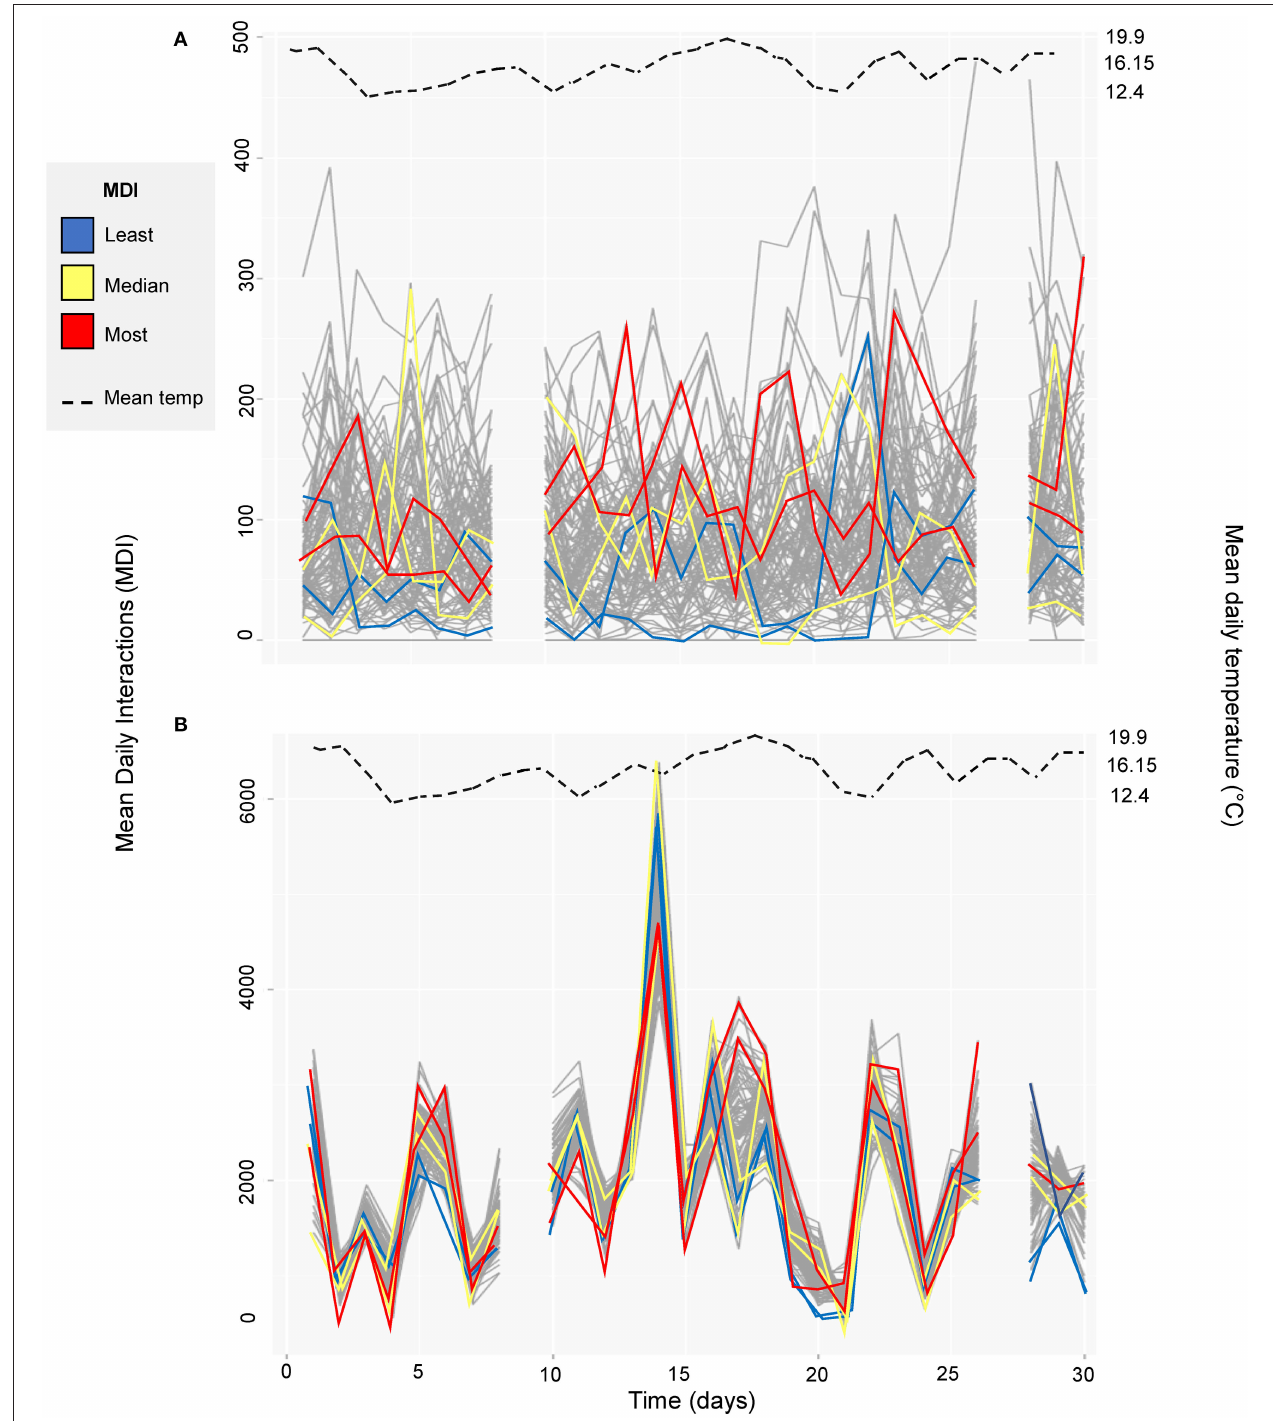
FIGURE 4 | Mean daily interactions across time (01/10/2014 to 31/10/2014 with days excluded from the study omitted) in (A) feeding zone, and (B) non-feeding zone. An illustrative subset of individuals are highlighted: two individuals with the least mean daily interactions (blue, cow ID = 3124 and 3317), two with mean daily interactions closest to the median value (yellow, cow ID = 2602 and 3132) and two with the highest mean daily interactions (red, cow ID = 635 and 3361). Data for each individual cow is indicated with a gray line. Mean daily temperature is shown with the dashed black line.